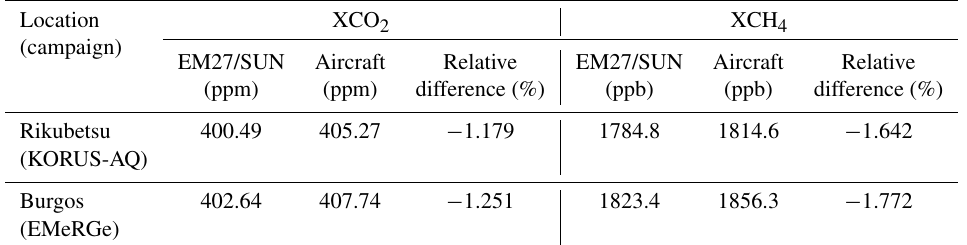
Table 4. Comparison of EM27/SUN data with aircraft XCO 2 and XCH 4 data. The air-mass-independent correction factors derived in this study are not yet applied to the EM27/SUN data. The relative differences are calculated as follows: (EM27/SUN − aircraft)/aircraft ×